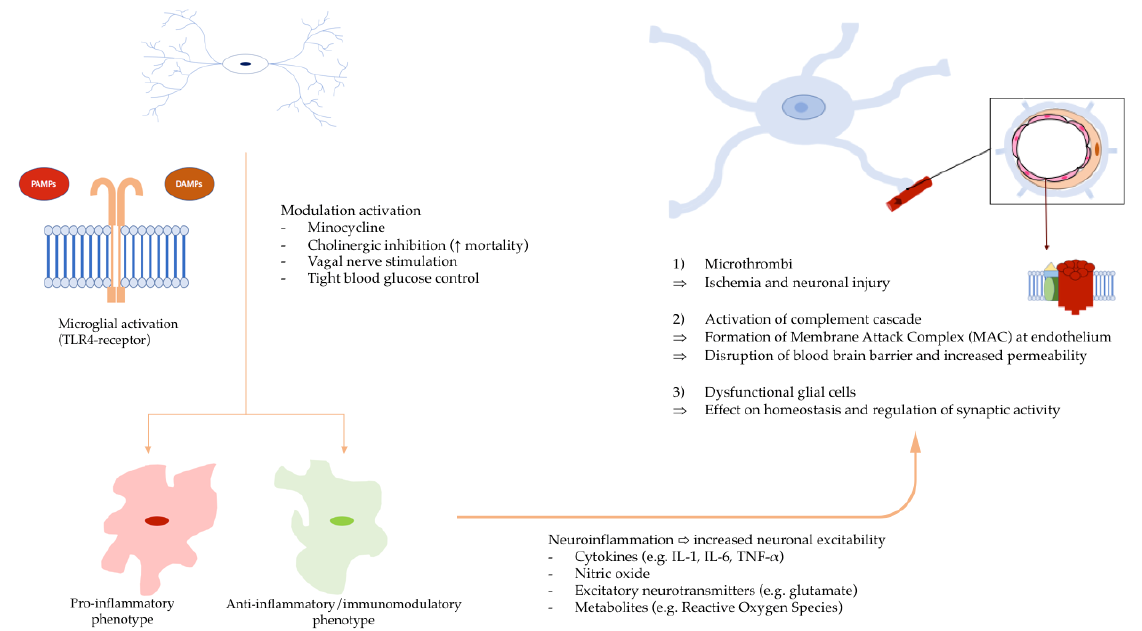
Figure 3. Microglial activation leading to neuroinflammation. Microglia can take on either anti- or pro-inflammatory phenotypes. In their pro-inflammatory state, cytokines, nitric oxide, excitatory neurotransmitters and metabolites (such as reactive oxygen species) are released in the brain parenchyma. Multiple experimental interventions have shown promising results in modulating microglial activity. In addition to the direct effects of microglial activation on neurons, neuroinflammation may also contribute to SAE through its effects on the microvasculature of the brain. Inflammation can lead to the formation of microthrombi in the brain, which can cause ischemia and further neuronal injury. Additionally, the activation of the complement cascade can lead to the formation of the membrane attack complex (MAC), which can damage the endothelial cells, leading to blood – brain barrier breakdown and increased permeability.